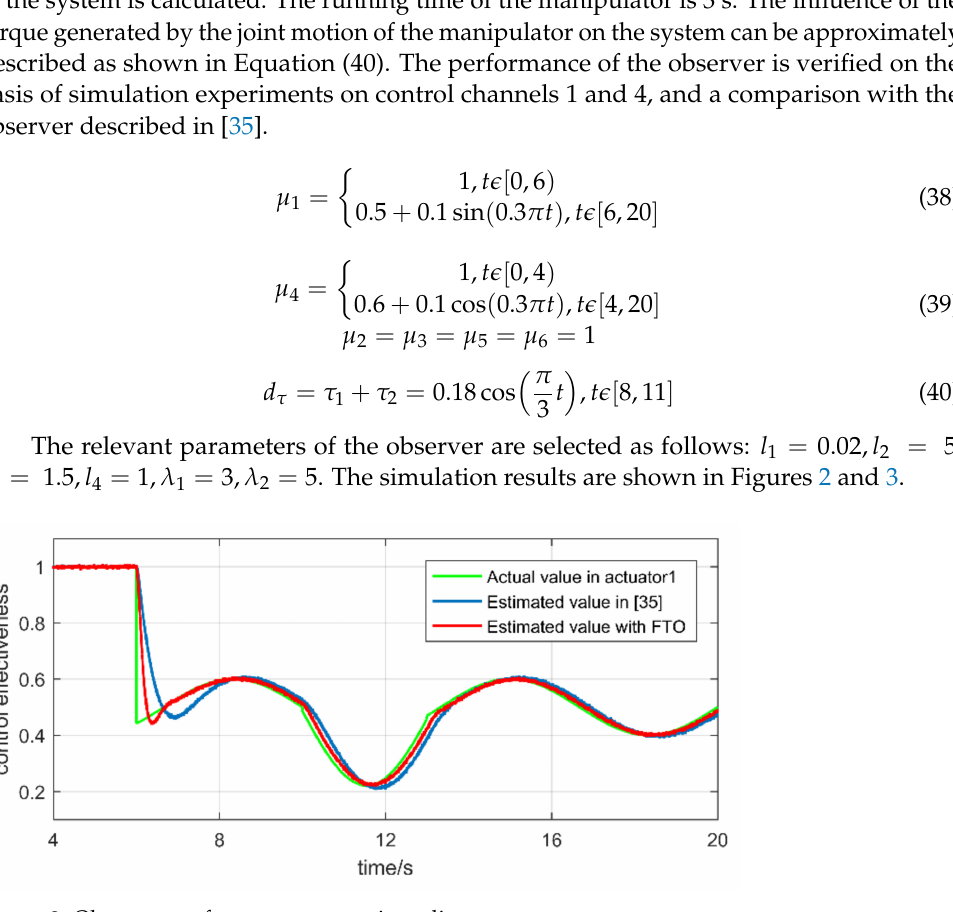
Figure 2. Observer performance comparison diagram.